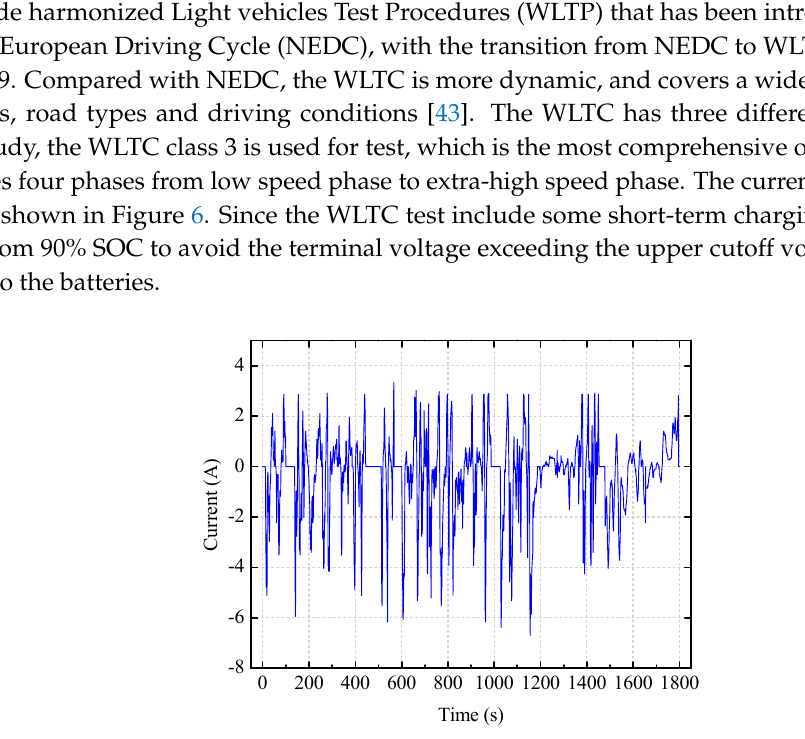
Figure 6. The current profile in WLTC test.